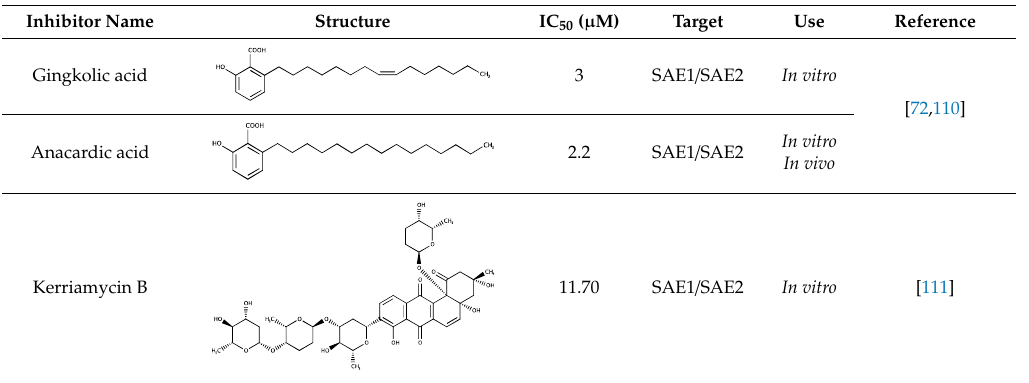
Table 1. Inhibitors of SUMO activating and conjugating enzymes. List of the small molecules, which inhibit SUMO conjugation. The IC50 are those obtained with purified recombinant enzymes or on cell lines. Only the molecules that were either validated on cells in vitro or in vivo in mouse models are indicated. Only one is being used in humans (TAK-981).